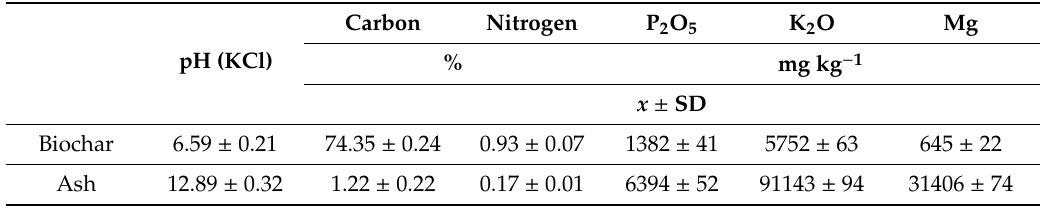
Table 3. Value of pH, contents of absorbable forms of macro-elements, as well as percent contents of carbon and nitrogen in the biochar and biomass